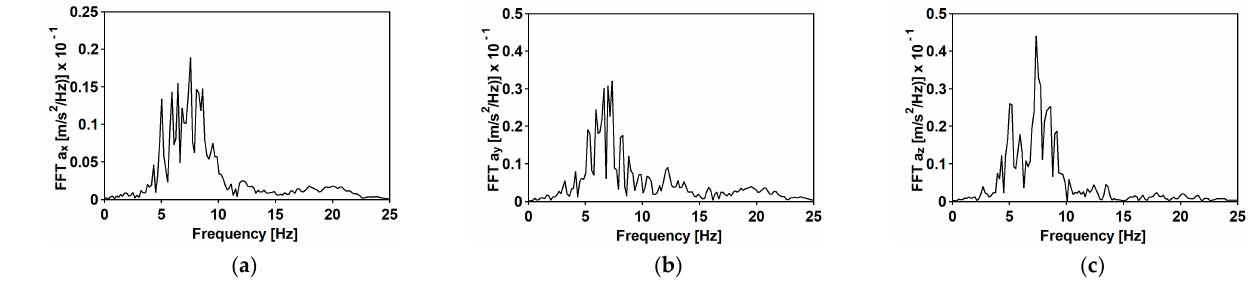
Figure 8. Fourier spectra of the first mining-induced shock: ( a ) horizontal direction WE; ( b ) horizontal direction NS; ( c ) vertical direction Z.